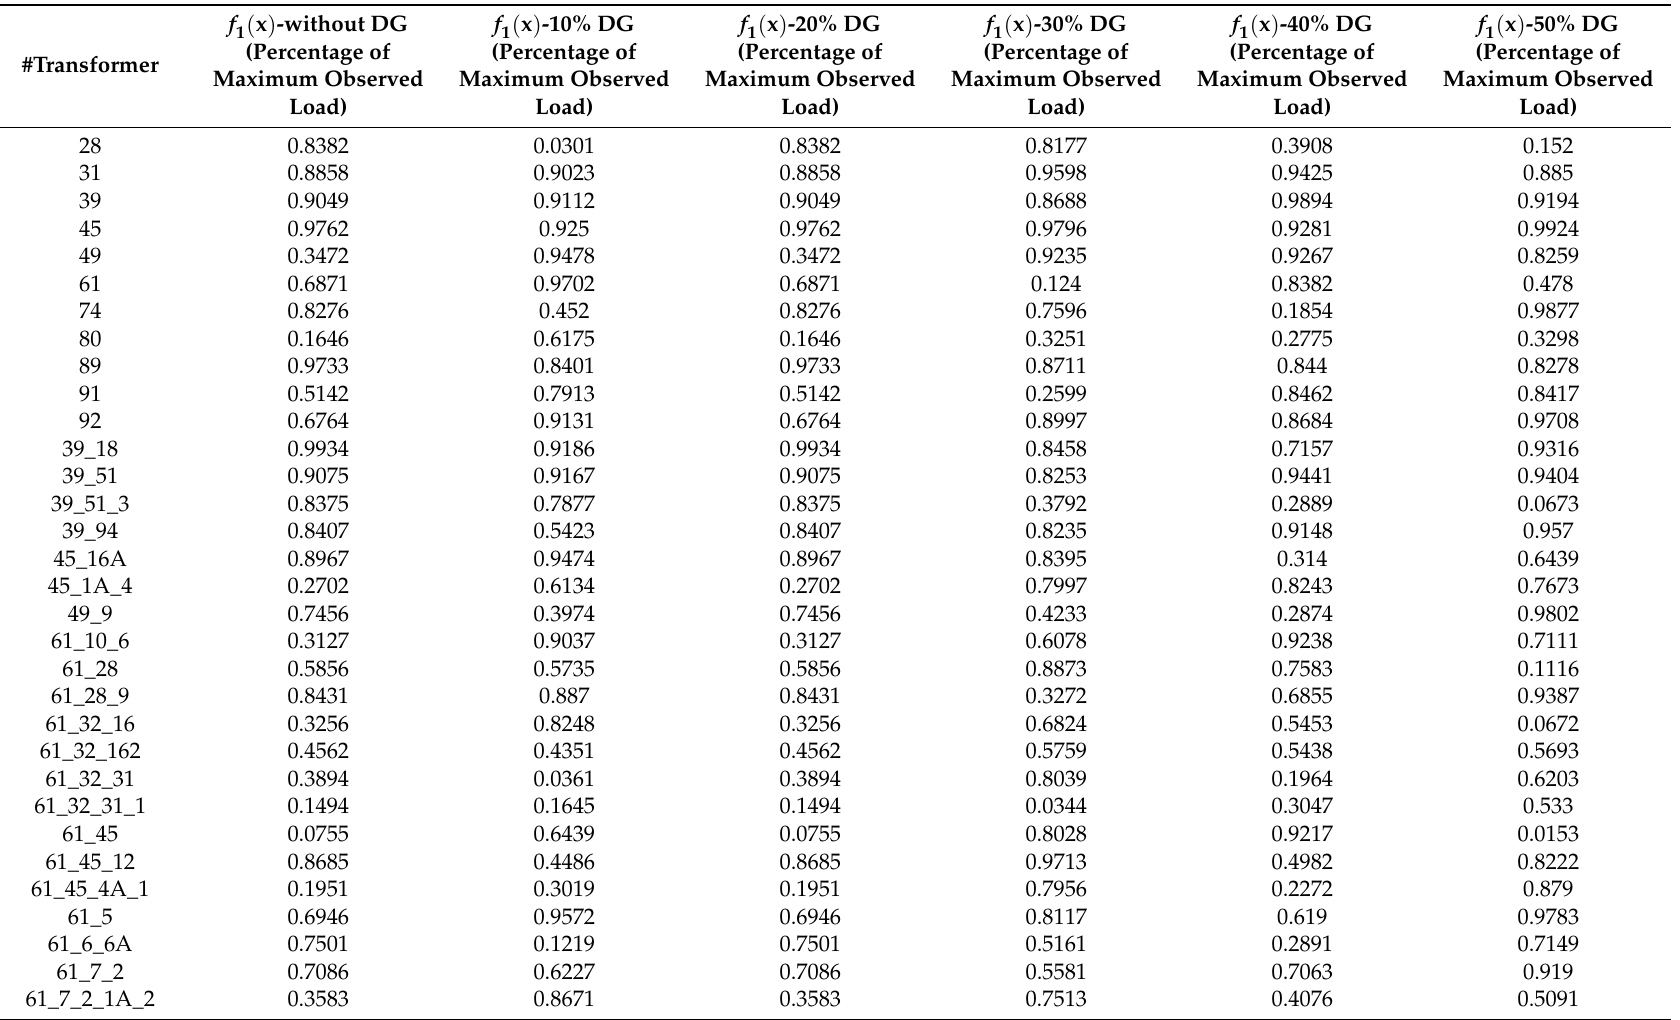
Table 1. Optimal loading per node according to f 1 ( x ) for increasing production up to 50% of the distributed generator’s installed